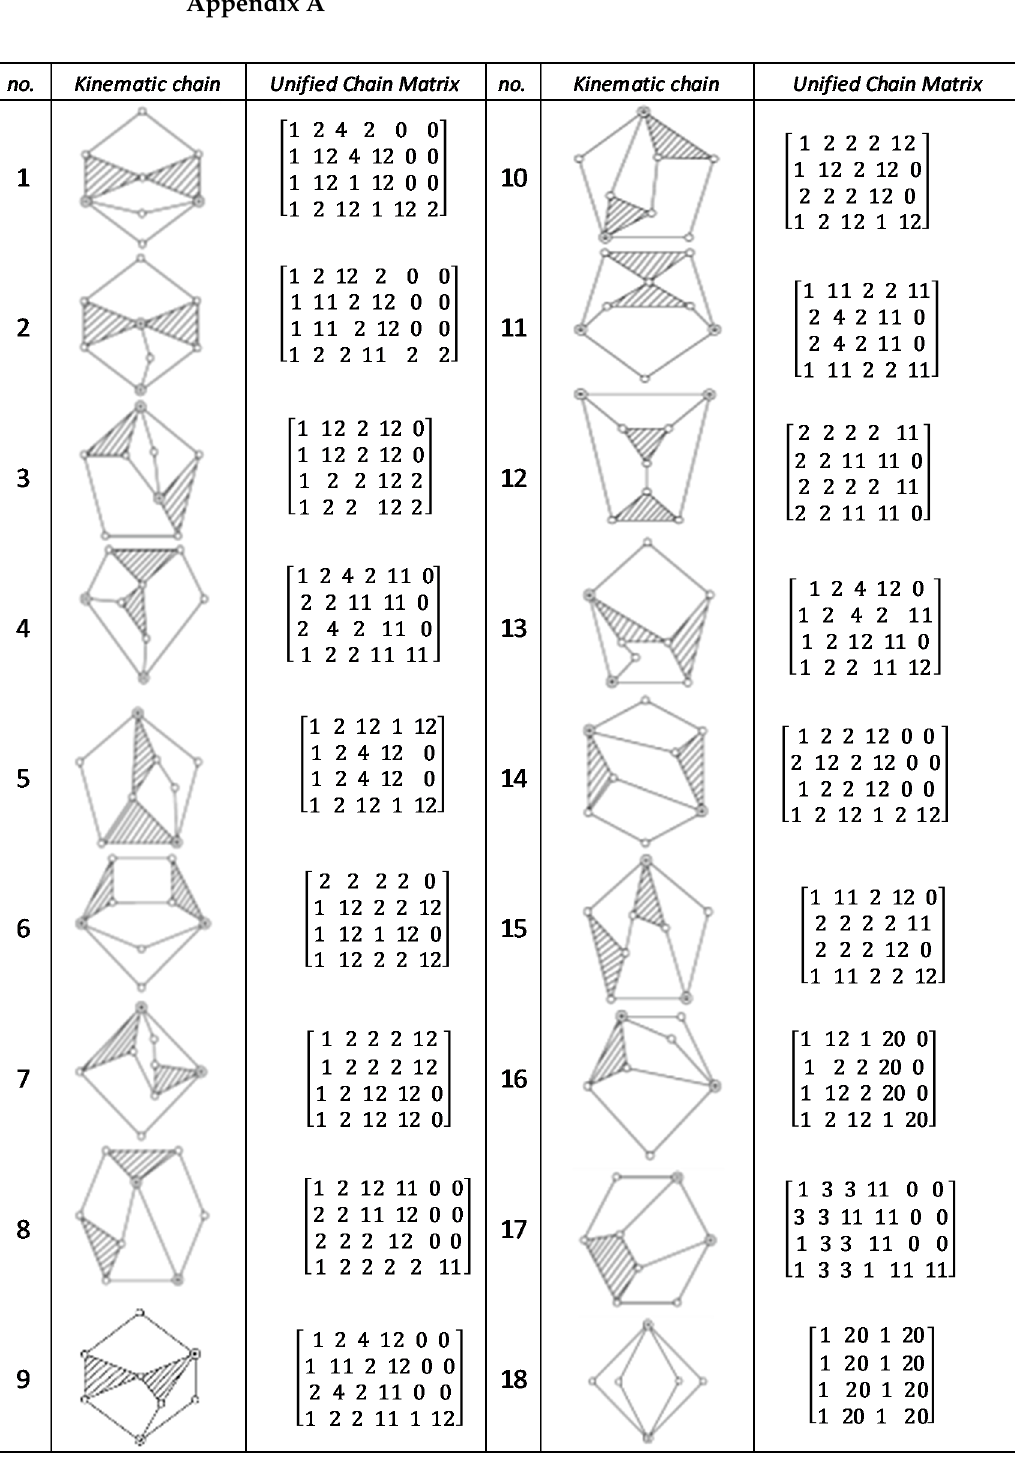
Figure A1. Unified chain matrix, UCM, for all 8 links 1-DOF KCs with 2 multiple joints [25].